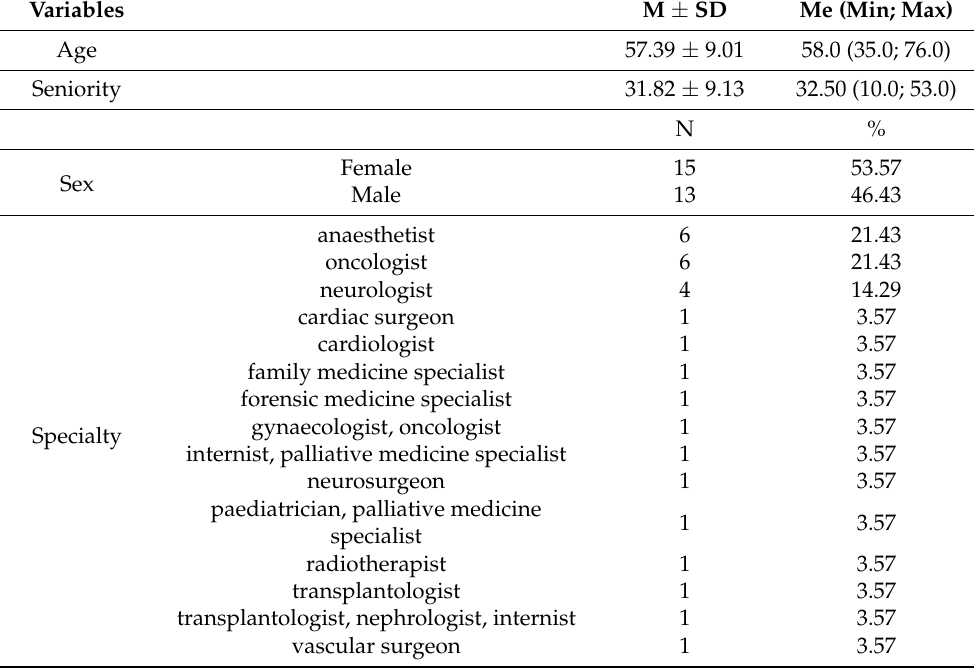
Table 2. Characteristics of the